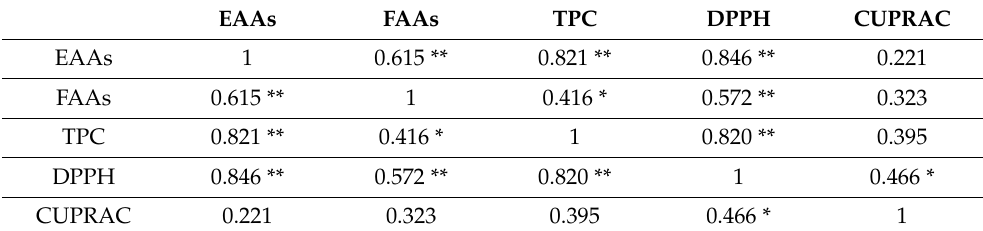
Table 4. Pearson correlation matrix of the EAAs, FAAs, TPC, and antioxidant capacities of probiotic whey beverages enriched with kiwi